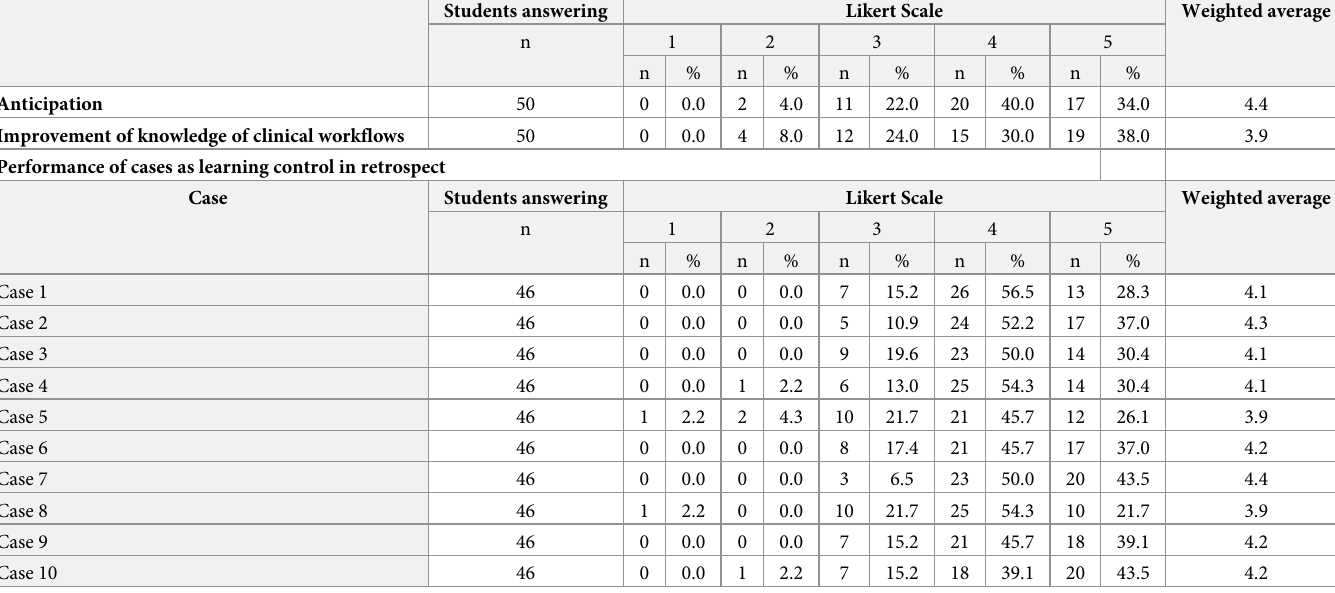
Table 2. Evaluation results after all cases in